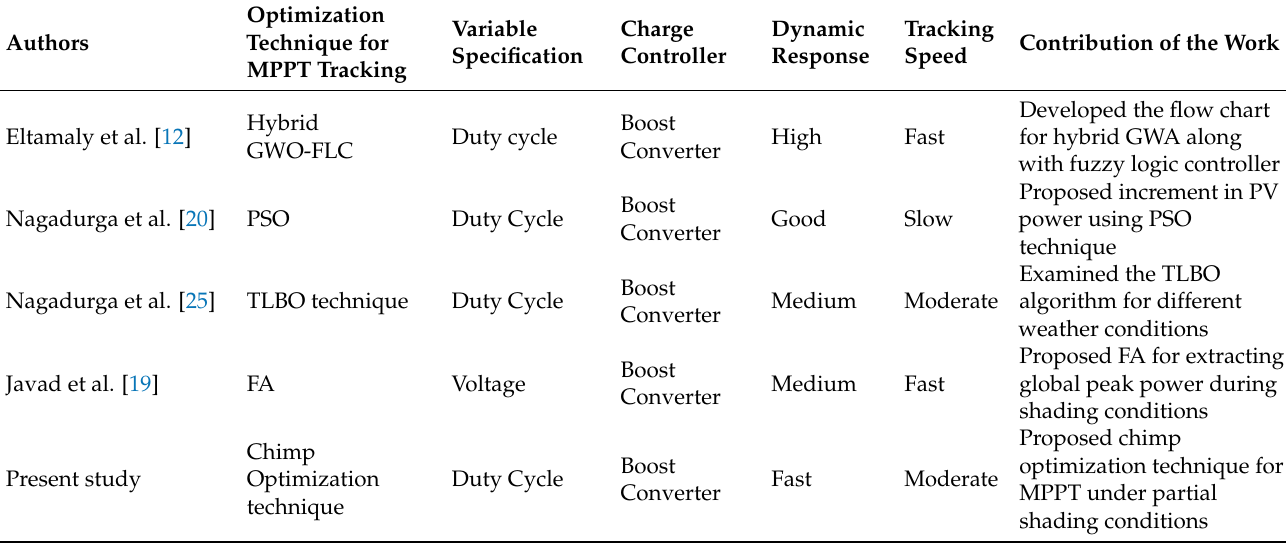
Table 7. Summary of the comparison of soft computing implemented in this work with the recent literature.